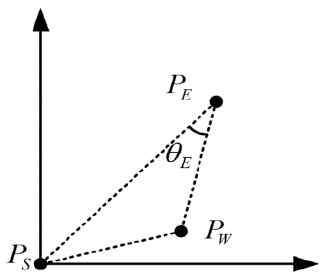
Figure 8. Schematic diagram of target angle.